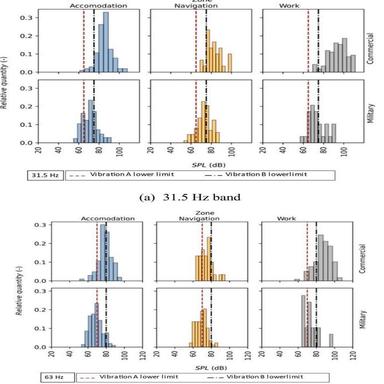
Vibrations induced by LF noise are classified by zone and ship typology.